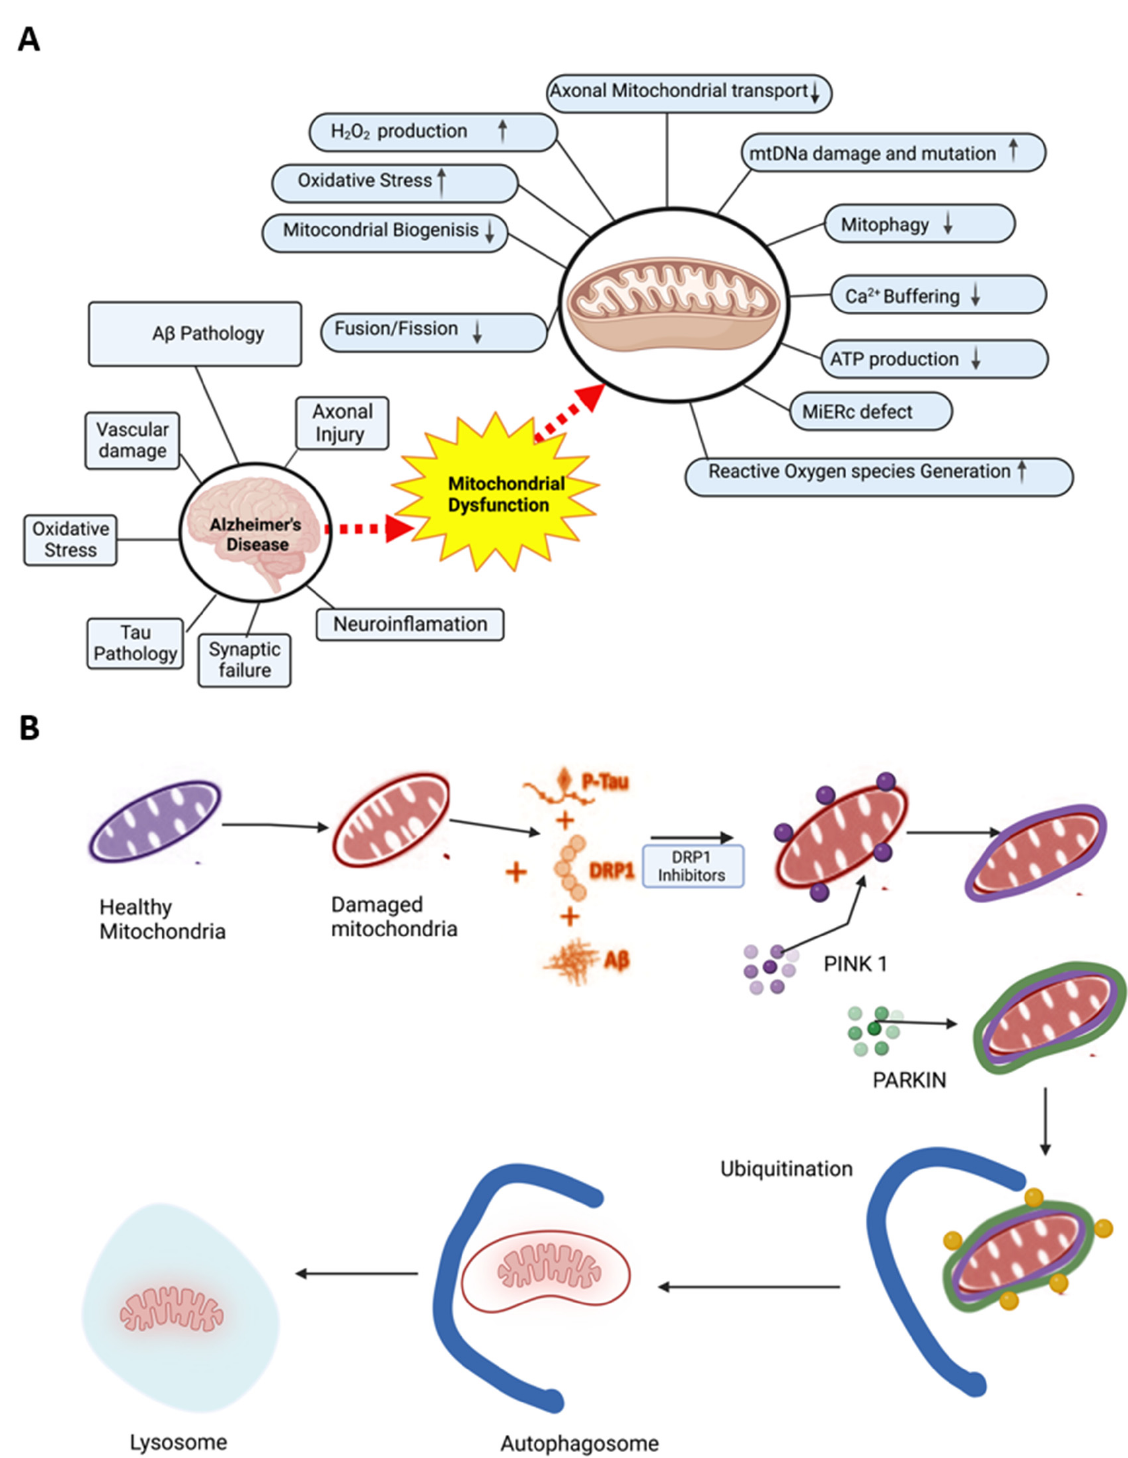
Figure 2. Mitochondrial dysfunction in Alzheimer’s disease and mitochondria-based therapeutics mechanism. ( A ) Mitochondrial dysfunction in the pathogenesis of AD results in the loss of mitochondrial structure and function that affects axonal transport, hydrogen peroxide production, mitochondrial biogenesis and dynamics, mitophagy, ER-mitochondria interaction, mitophagy, energy production, and ROS generation, as well as causing oxidative stress. ( B ) Mitophagy as a potential therapeutic target for treating dementia.